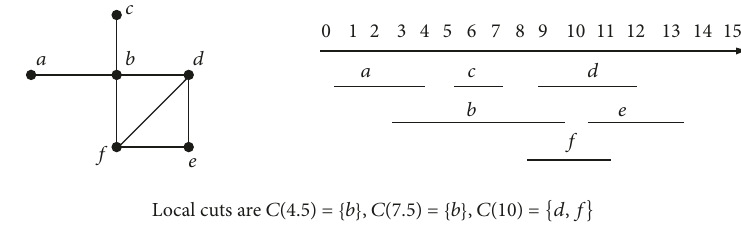
Figure 1: An example of an interval graph and its local cuts.